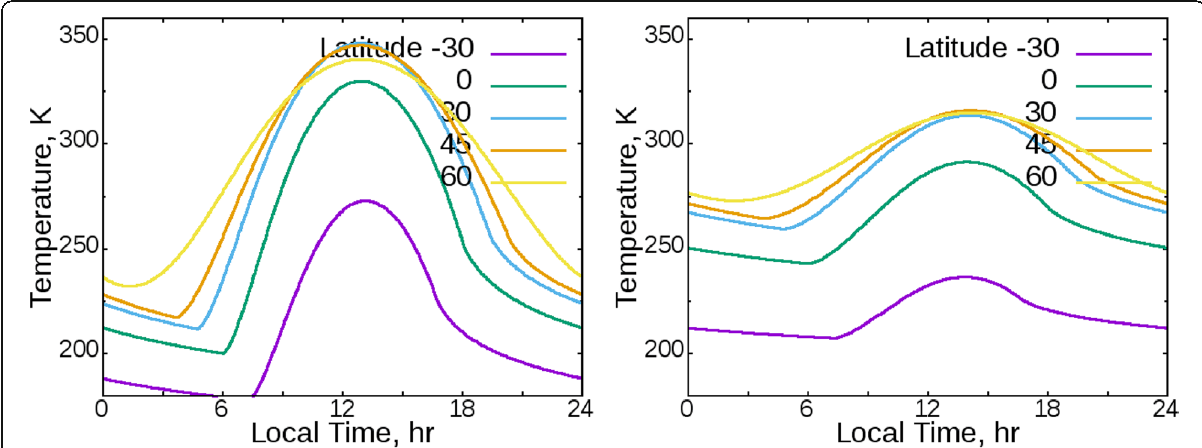
Fig. 9 Left: similar to Fig. 8, but for a case with sub-solar latitude of 30, i.e., a tilted spin axis. Left: the thermal inertia is 200 J m − 2 s − 1/2 K − 1 . Right: thermal inertia is 1000 J m − 2 s − 1/2 K − 1